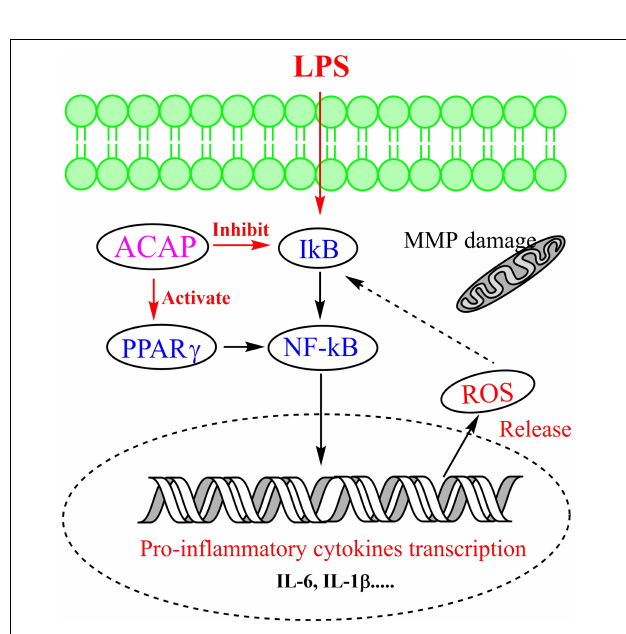
FIGURE 6 | The possible anti-inflammatory mechanism of